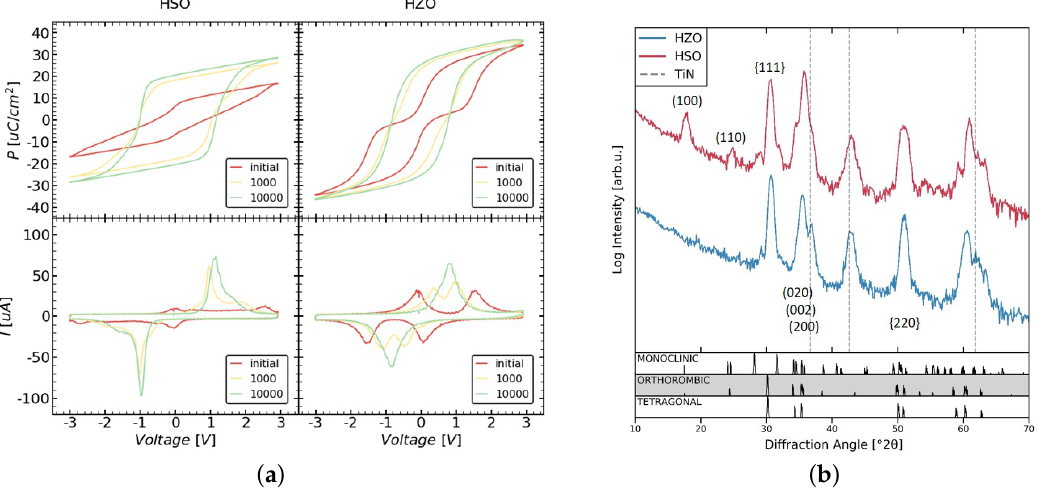
Figure 1. Electrical measurements ( a ) and grazing incident X-ray diffraction (GIXRD) patterns ( b ) of the Si- and Zr-doped HfO 2 (HSO/HZO) metal-ferroelectric-metal (MFM) sample. ( a ) Polarization–voltage (P–V) as well as the corresponding current–voltage (I–V) loops before and after cycling. Both samples exhibit a pronounced wake-up effect. GIXRD patterns ( b ) show a larger monoclinic phase fraction in case of HSO. Furthermore, differences in the intensity ratio of specific peaks (e.g., (100) and (110)) of the same phase indicate a strongly pronounced texture inside the HSO